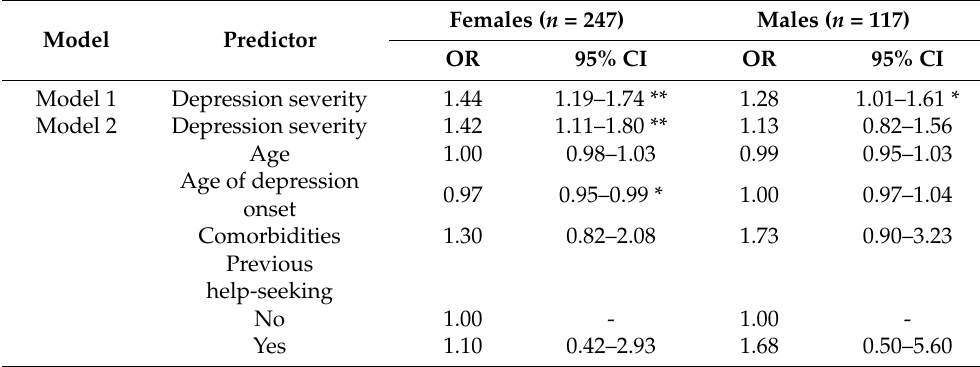
Table 2. Regression for suicidal